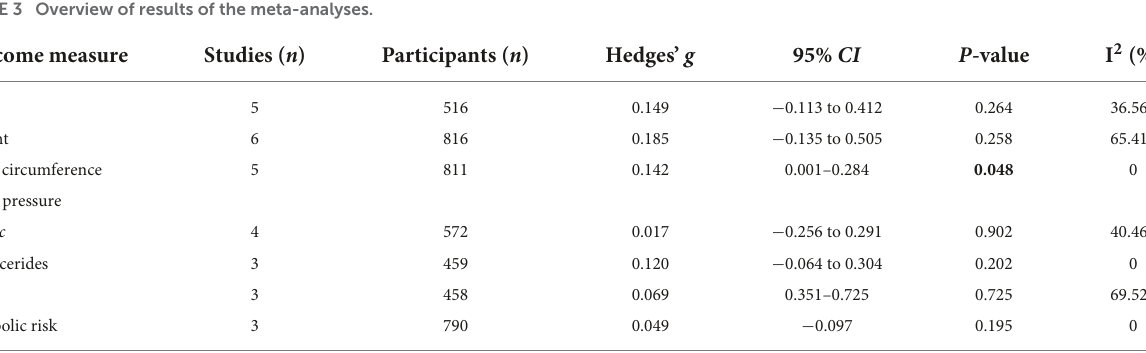
TABLE 3 Overview of results of the